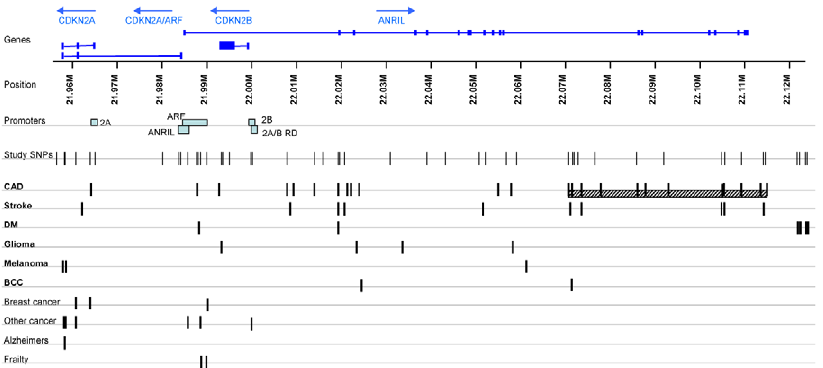
Figure 1. SNPs associated with disease in the chromosome 9p21.3 region. Genes are illustrated in blue at the top, with arrows representing the direction of transcription. SNPs typed in our study and SNPs associated with various diseases are represented by black bars. Diseases in bold are those with association data from genomewide association studies. The hatched box represents the core risk haplotype for CAD defined by Broadbent et al [35]. Promoter regions for each gene are shown as pale blue boxes. DM=diabetes mellitus type II; BCC=basal cell carcinoma.